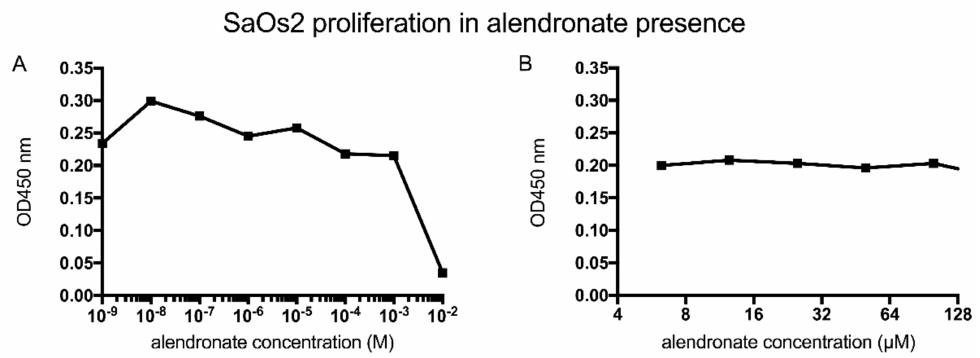
Figure 6. Identification of the range of alendronate concentrations that do not interfere with bone cell proliferation. ( A ) SaOs2 cells’ proliferation in the presence of a 10-fold dilution series of alendronate. ( B ) SaOs2 cells’ proliferation in the presence of a 2-fold dilution series extracted from the previous test so as to not decrease the expansion capacity of the cells.